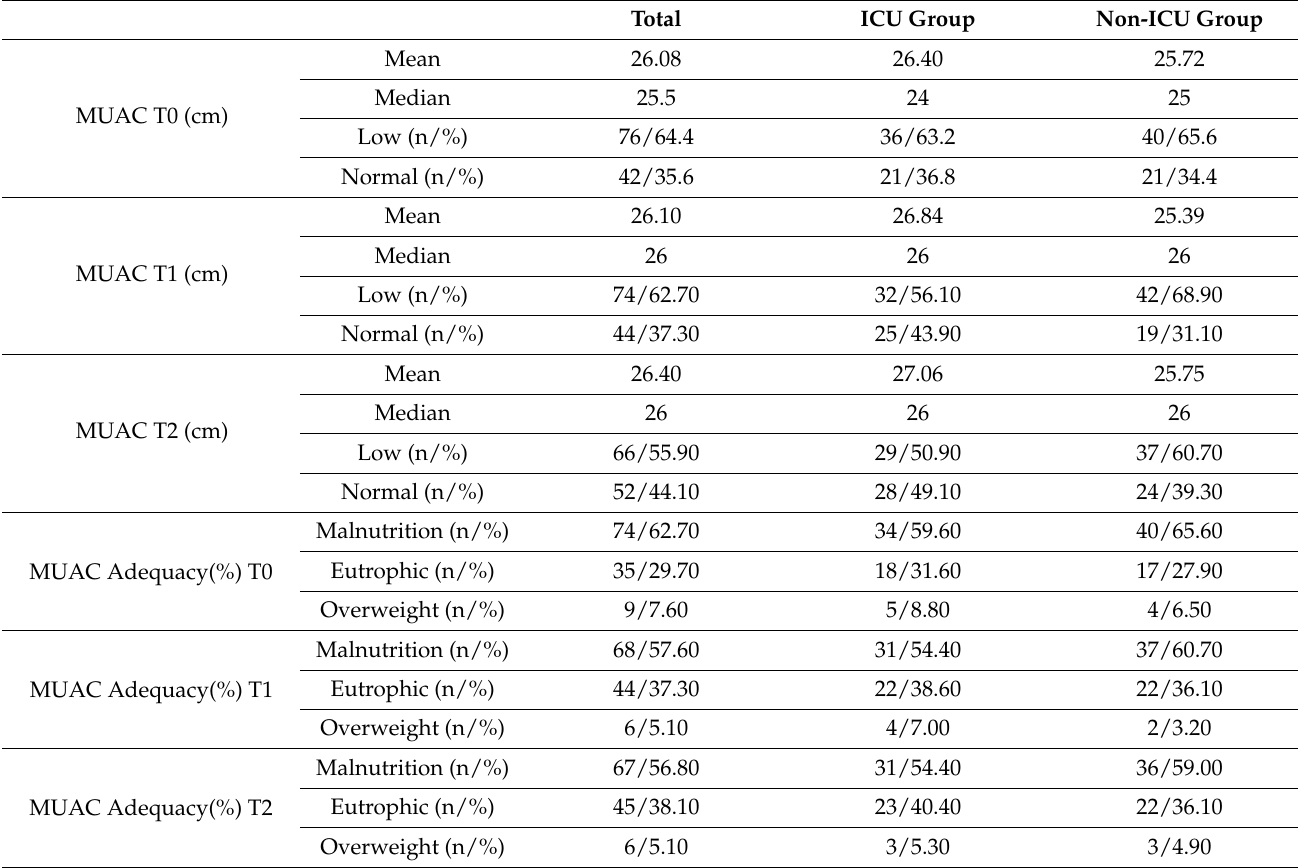
Table 2. Characterization of subjects and respective results Mid Upper Arm Circumference and from Mid Upper Arm Circumference Adequacy (%) in all evaluation moments (T0; T1;